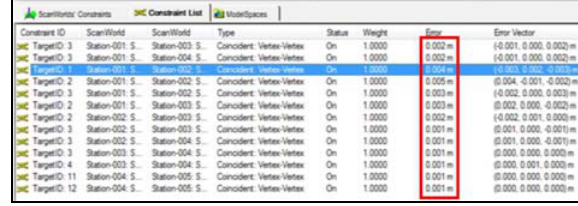
Figure 9. Error in the record through targets.